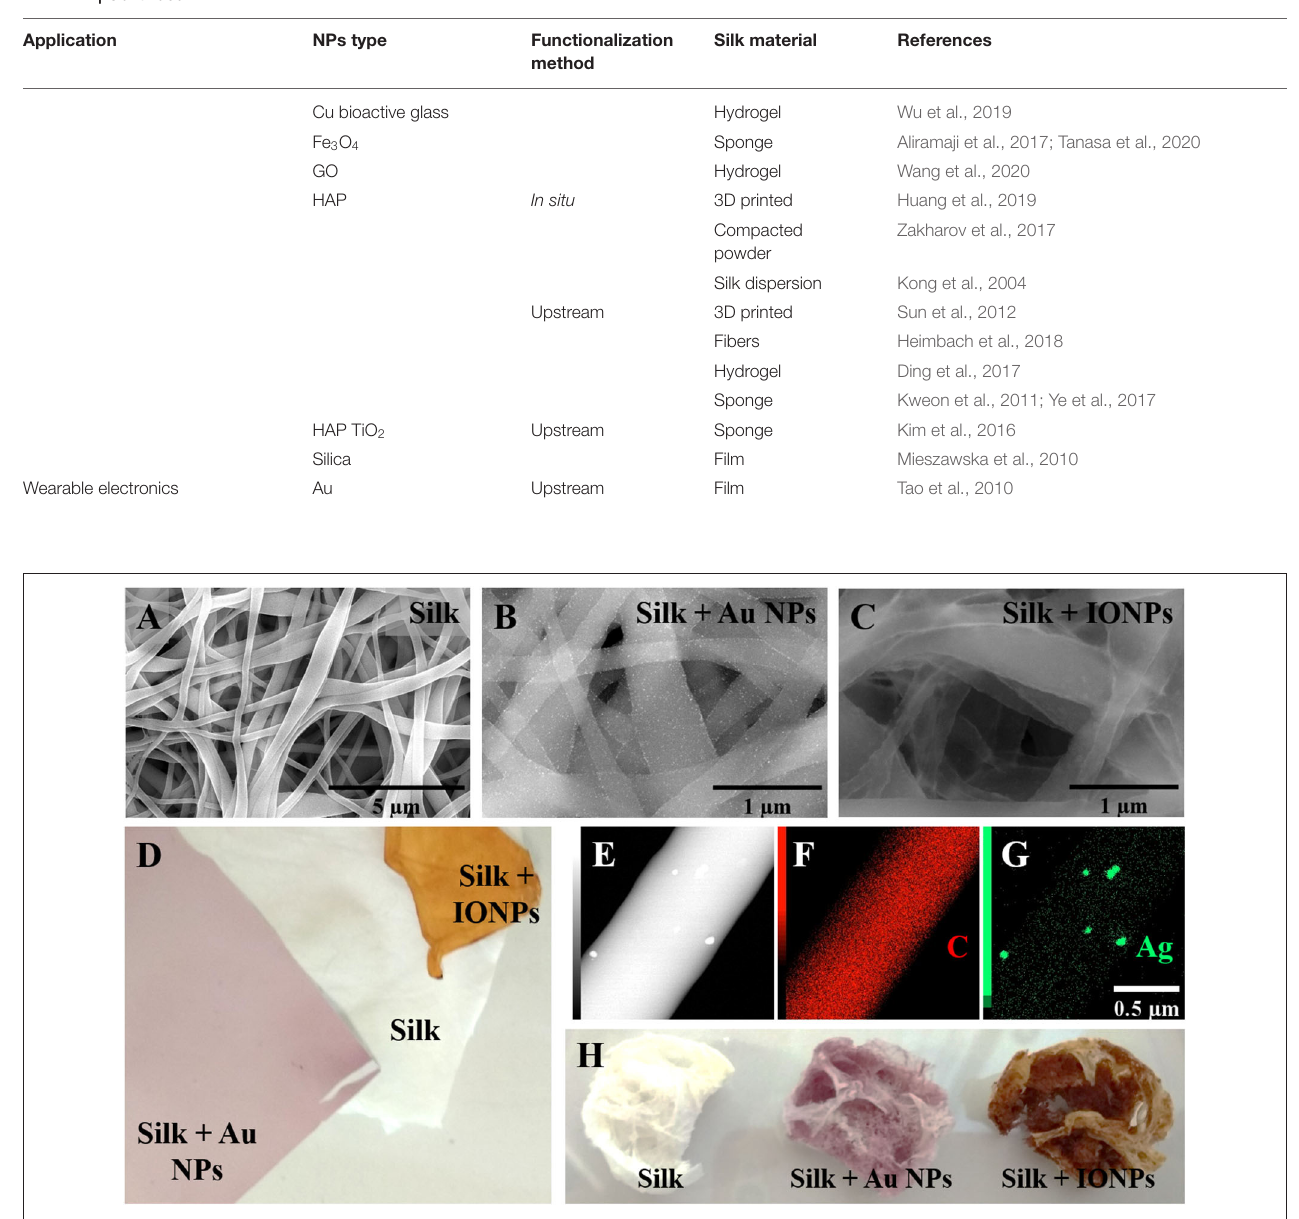
FIGURE 2 | Examples of silk bionanocomposites. Scanning Electron Microscopy view of electrospun silk fibers (A) with gold nanoparticles (Au NPs) (B) , iron oxide nanoparticles (IONPs) (C) or silver nanoparticles (Ag NPs) [ (E–G) , STEM-EDS with elemental mapping]. Macroscopic view of electrospun scaffolds (D) and sponges (H) with gold (Au NPs) and iron oxide nanoparticles (IONPs).